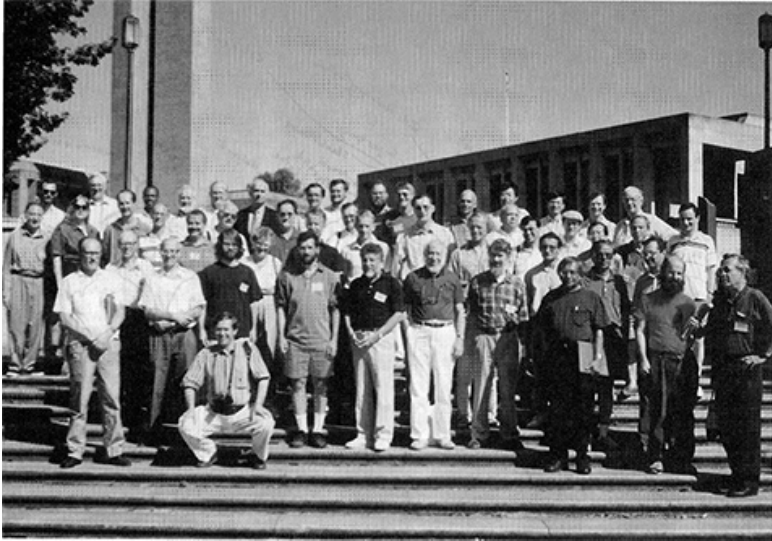
Figure 4: The participants of the conference Distributions with Fixed Marginals, Doubly Stochastic Measures, and Markov Oper- ators held in Seattle (see the proceedings in [39]) in 1993. Giorgio Dall’Aglio is the first standing on the left of the front